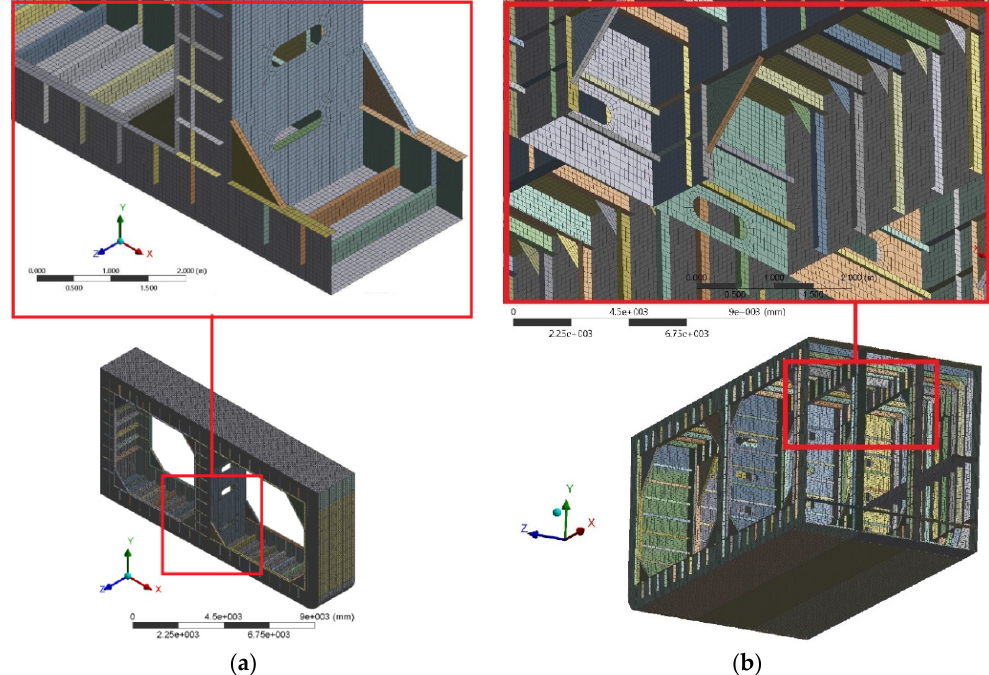
Figure 8. Mesh between two transversal frames of the FEM model of the barge midship section: ( a ) bottom plate, longitudinal bulkhead and bracket, and ( b ) main deck and longitudinal bulkhead.